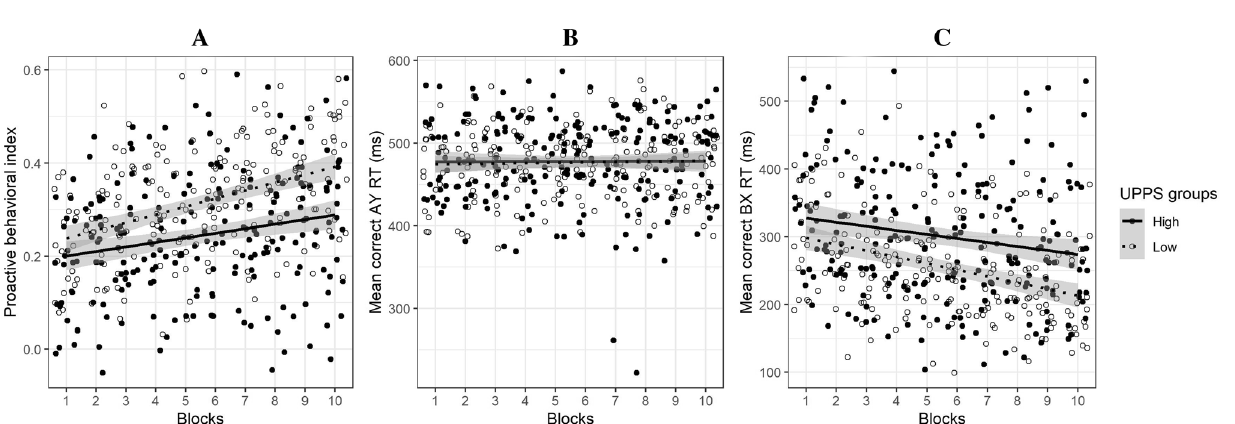
Figure 4. Results obtained in the impulsiveness groups for the PBI ( A ) and for the RTs in AY and BX trials ( B, C ) as a function of blocks. The high and the low impulsiveness groups (filled and empty dots, respectively) were created using the median of the UPPS score distribution. The proactive behavioral index (PBI) in the high impulsiveness group increased slower than the PBI in the low impulsiveness group ( A ). The difference in the PBI adaptation was due to a slower decrease in RTs in the BX trials in the high impulsiveness group compared to that observed in the low impulsiveness group ( C ) whereas RTs in the AY trials remained stable in both groups ( B ). The grey areas represent the 0.95 confidence interval